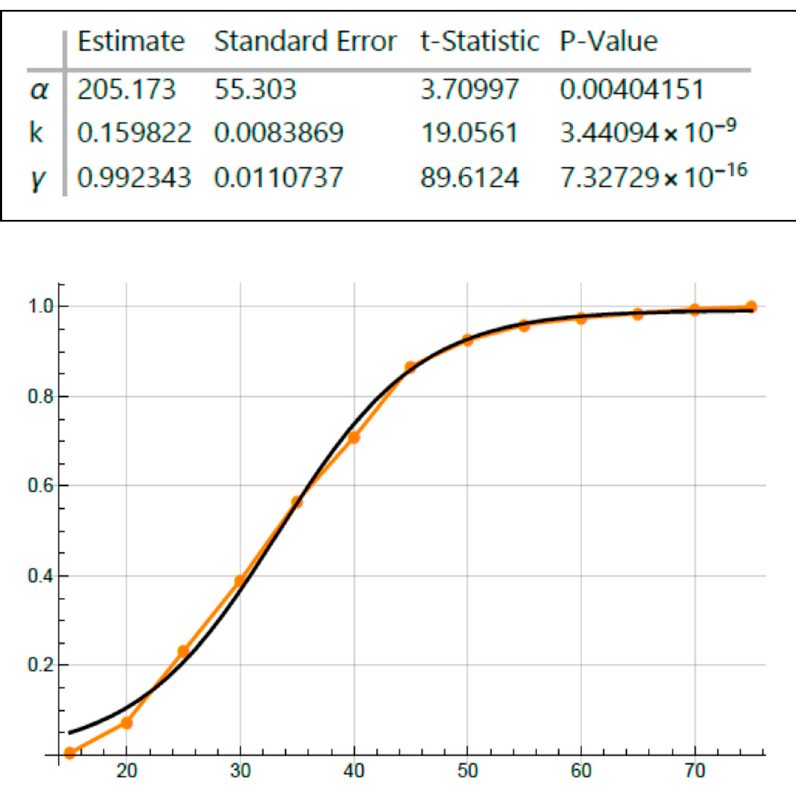
Figure 4. Fitting age-at-adenoma diagnosis data on sporadic tumor patients using the logistic equation.